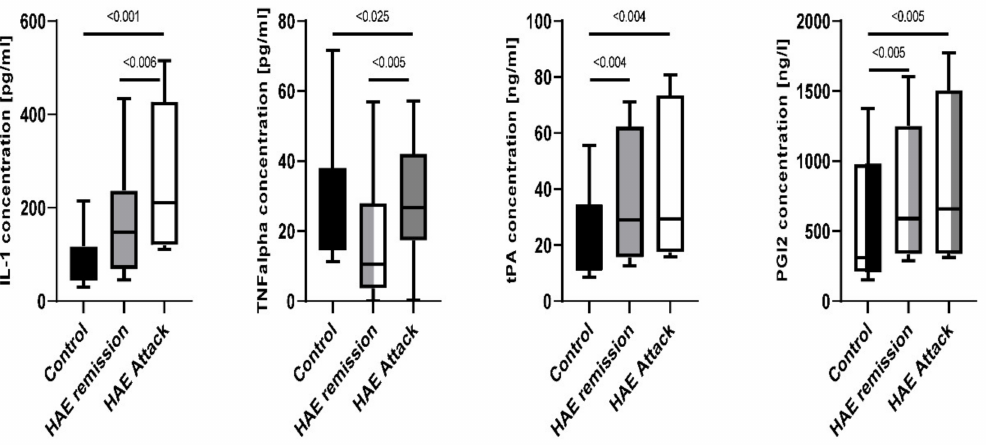
Figure 5. Disease-specific markers expression among HAE patients in attack and during remission compared to the healthy control